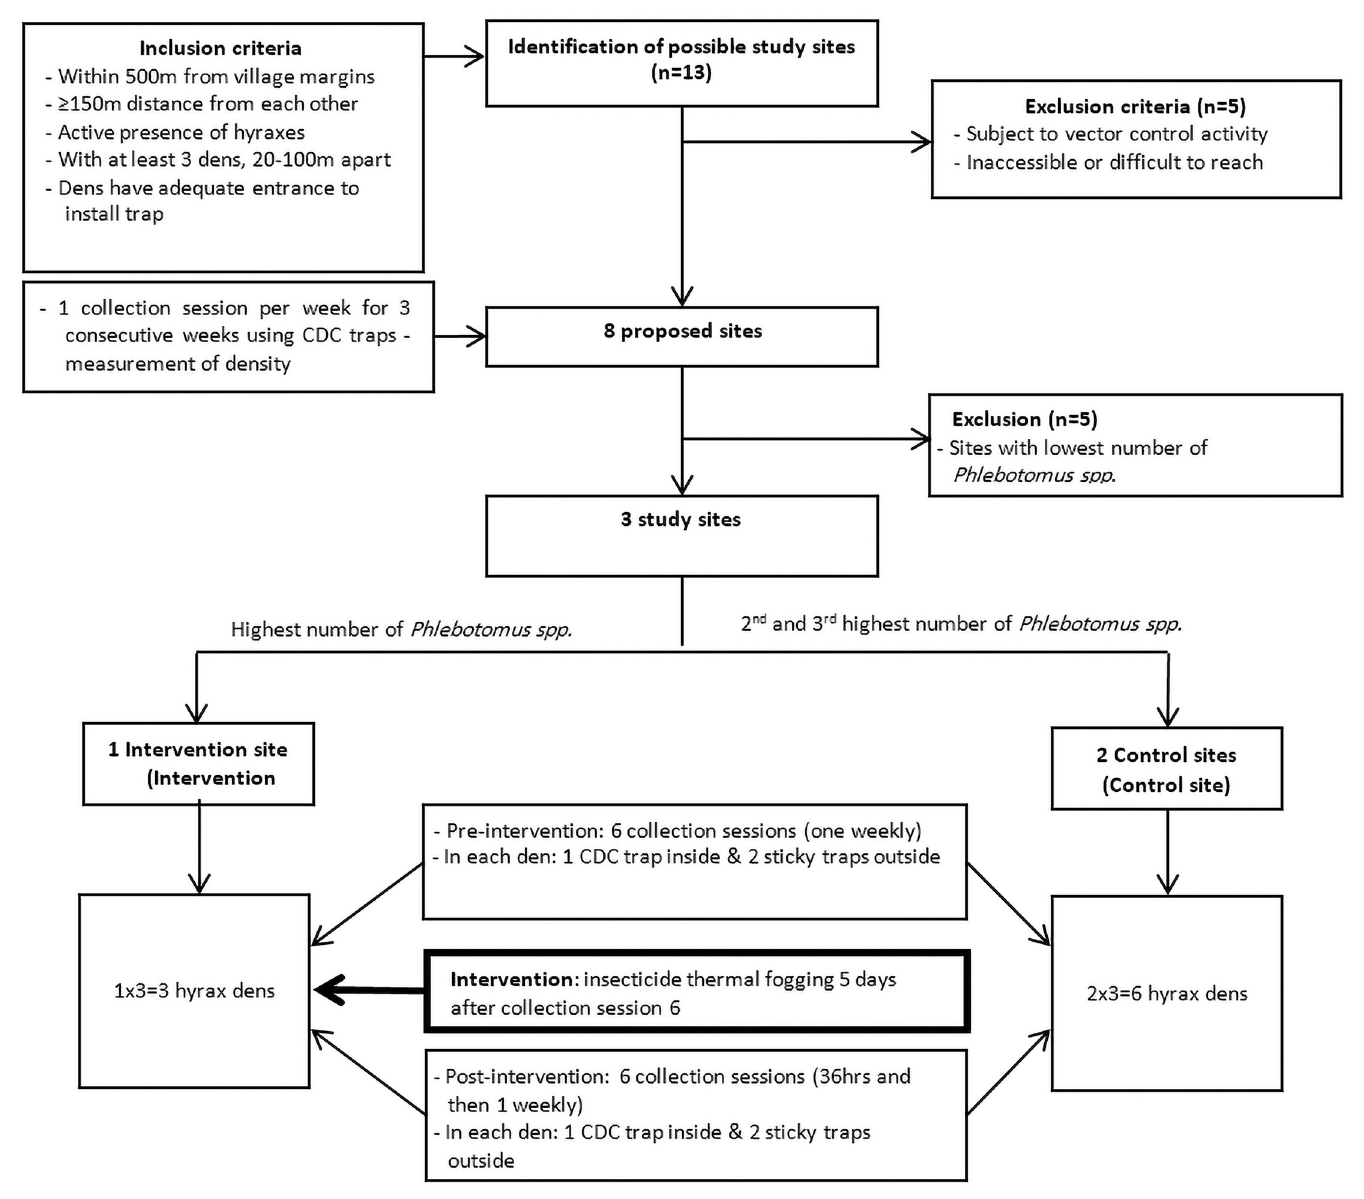
Fig 2. Flow diagram of study sites selection and study process, Tayasir, Palestine,